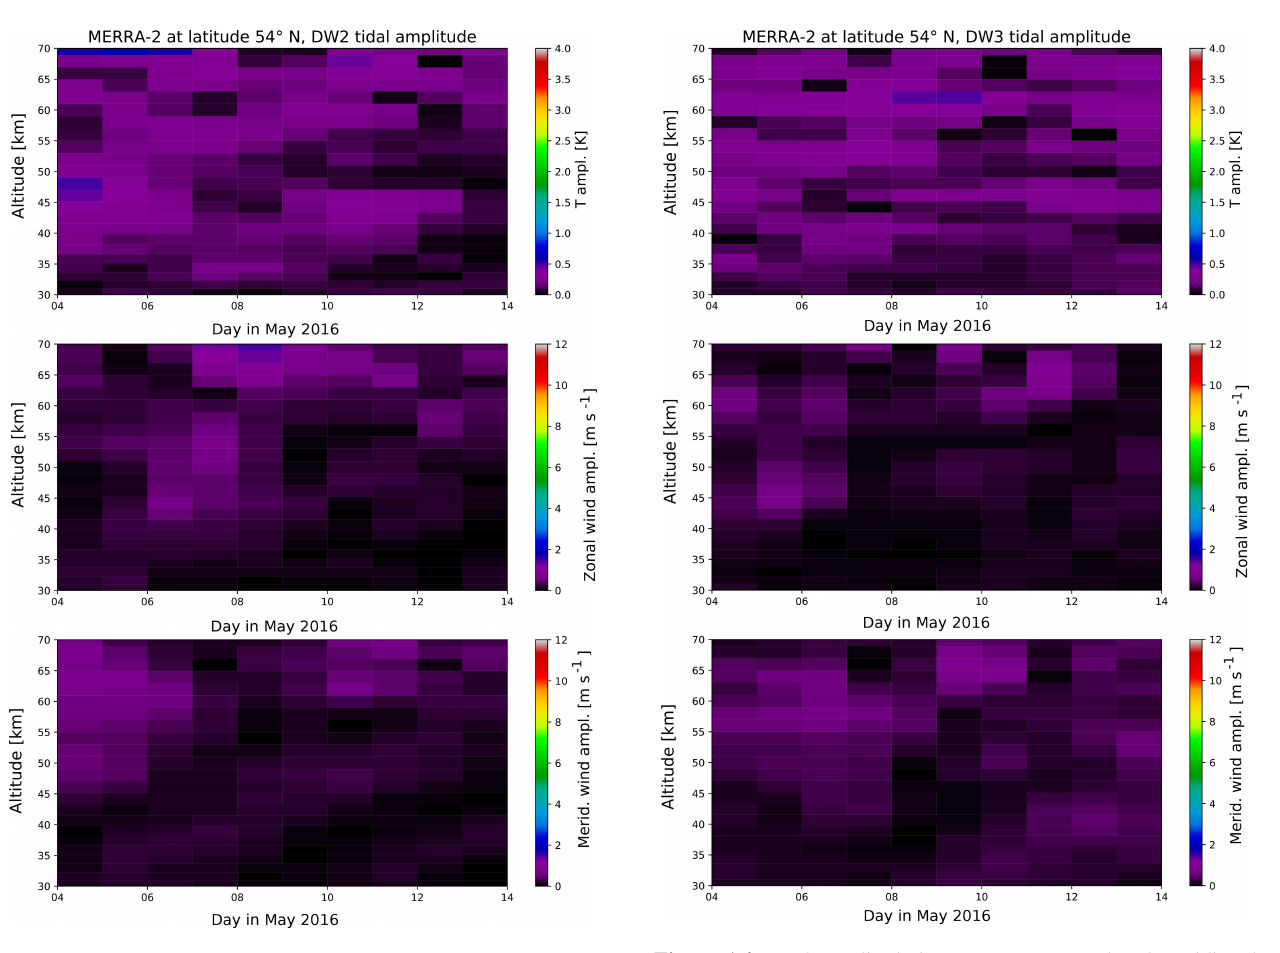
Figure A3. DW2 amplitude in temperature, zonal and meridional wind from global MERRA-2 fields at the latitude of 54 ◦ N.